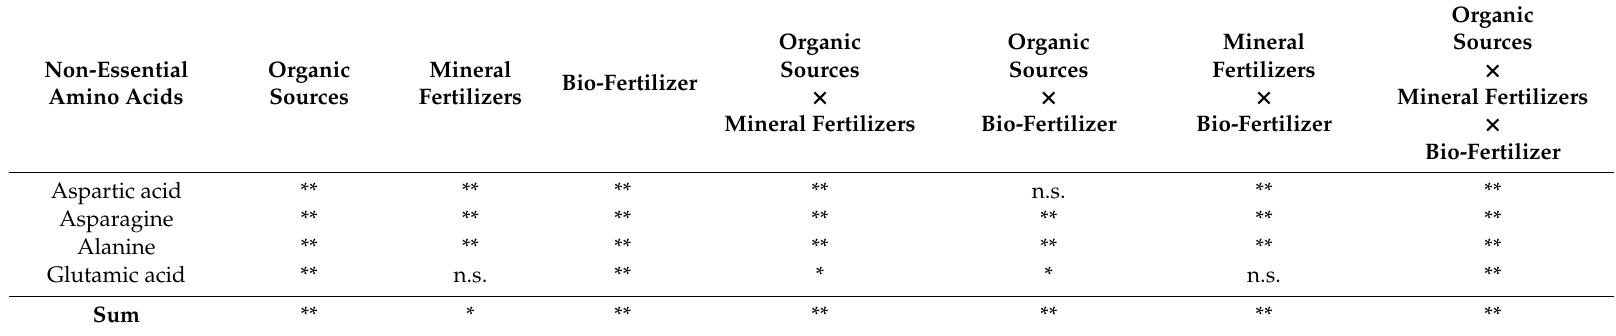
Table 6. Non-essential amino acids content. Significance of experimental factors and their interaction, the 2009-2011